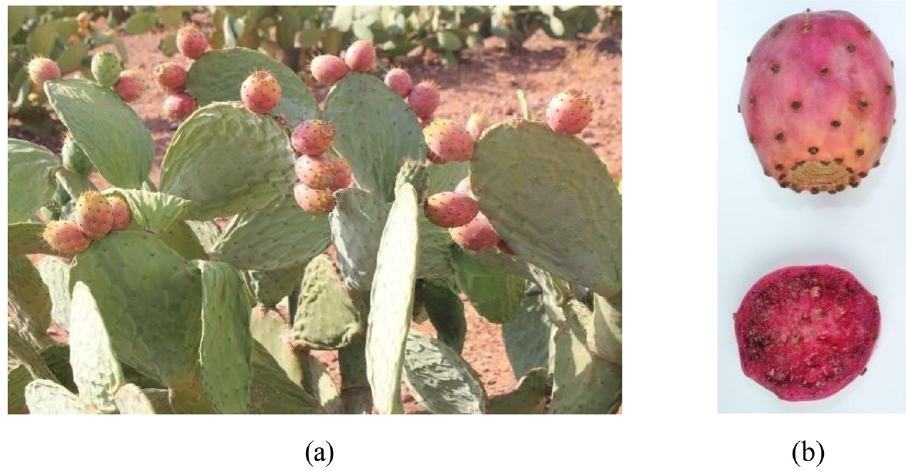
Figure 3: Akria ( Opuntia fi cus - indica ) variety: ( a ) plant of Akria variety and ( b ) fruit of Akria